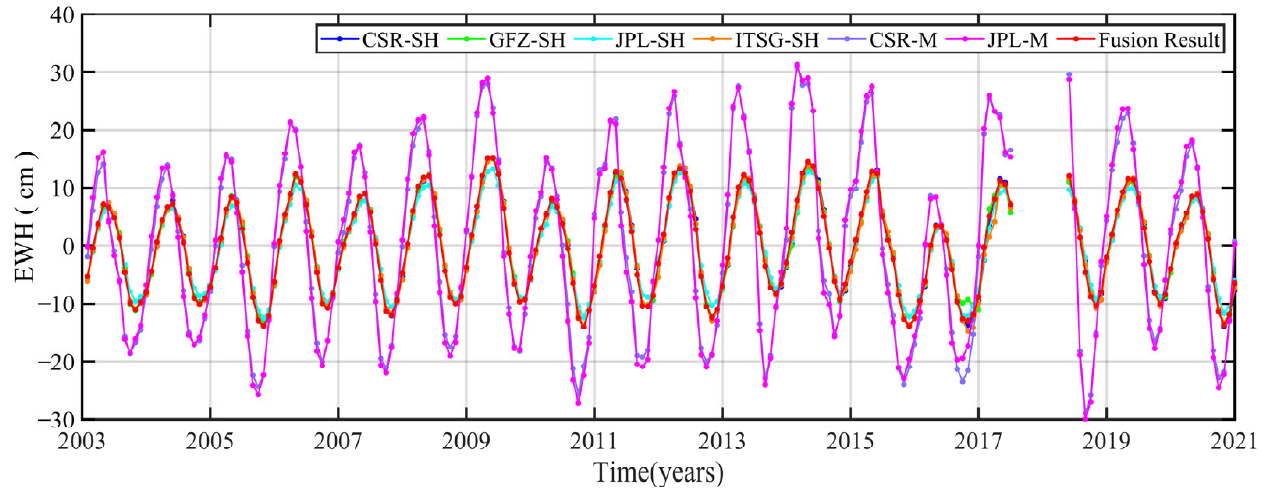
Figure 4. The spatial distribution of uncertainties of TWSC from fused results.